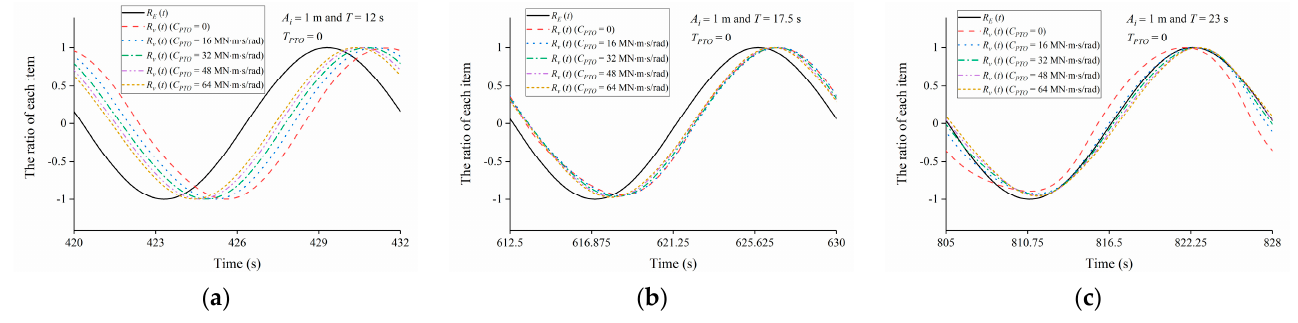
Figure 22. Time–history of the ratios of wave exciting moment and angular velocities of a no-friction flap ( T PTO = 0) for various values of PTO damping under unit-amplitude regular waves: ( a ) T = 12 s; ( b ) 𝑇 = 17.5 s , near the natural period (resonance); ( c ) 𝑇 = 23 s .